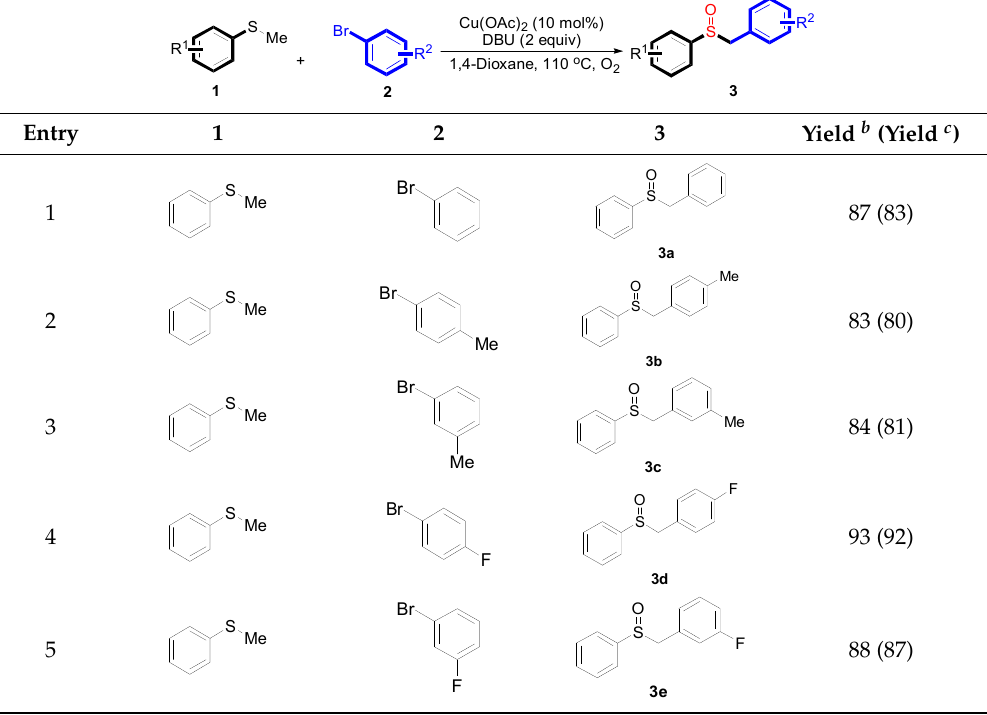
Table 2. Copper-catalyzed sulfoxidation of thioanisoles 1 with bromobenzenes 2 a .